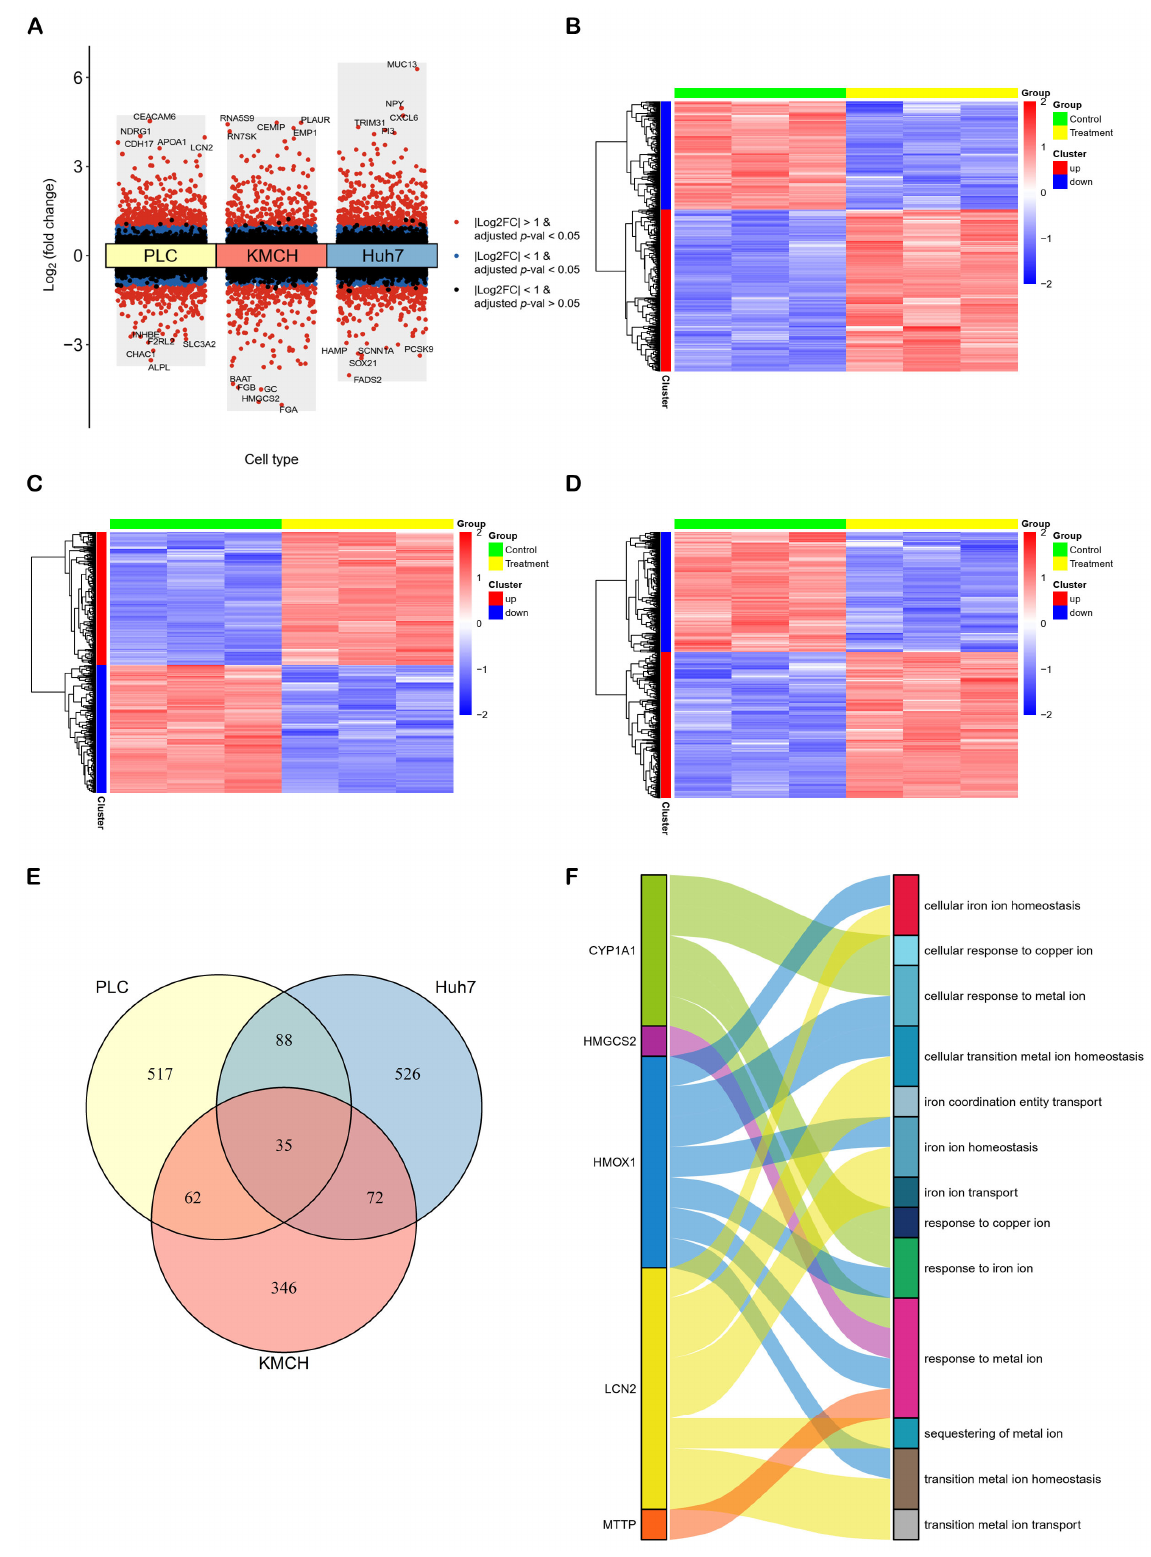
Figure 1. Differential expression analysis and functional annotation. ( A ) A volcano plot and ( B – D ) three heatmaps of DEGs showed that significant changes in mRNAs caused by curcumin in PLC, KMCH and Huh7 cell lines, respectively. ( E ) Thirty-five common genes were significantly regulated by curcumin in all three cell lines. ( F ) Among the 35 genes, CYP1A1 , HMGCS2 , HMOX1 , LCN2 and MTTP were enriched in biological processes related to metal ion homeostasis.